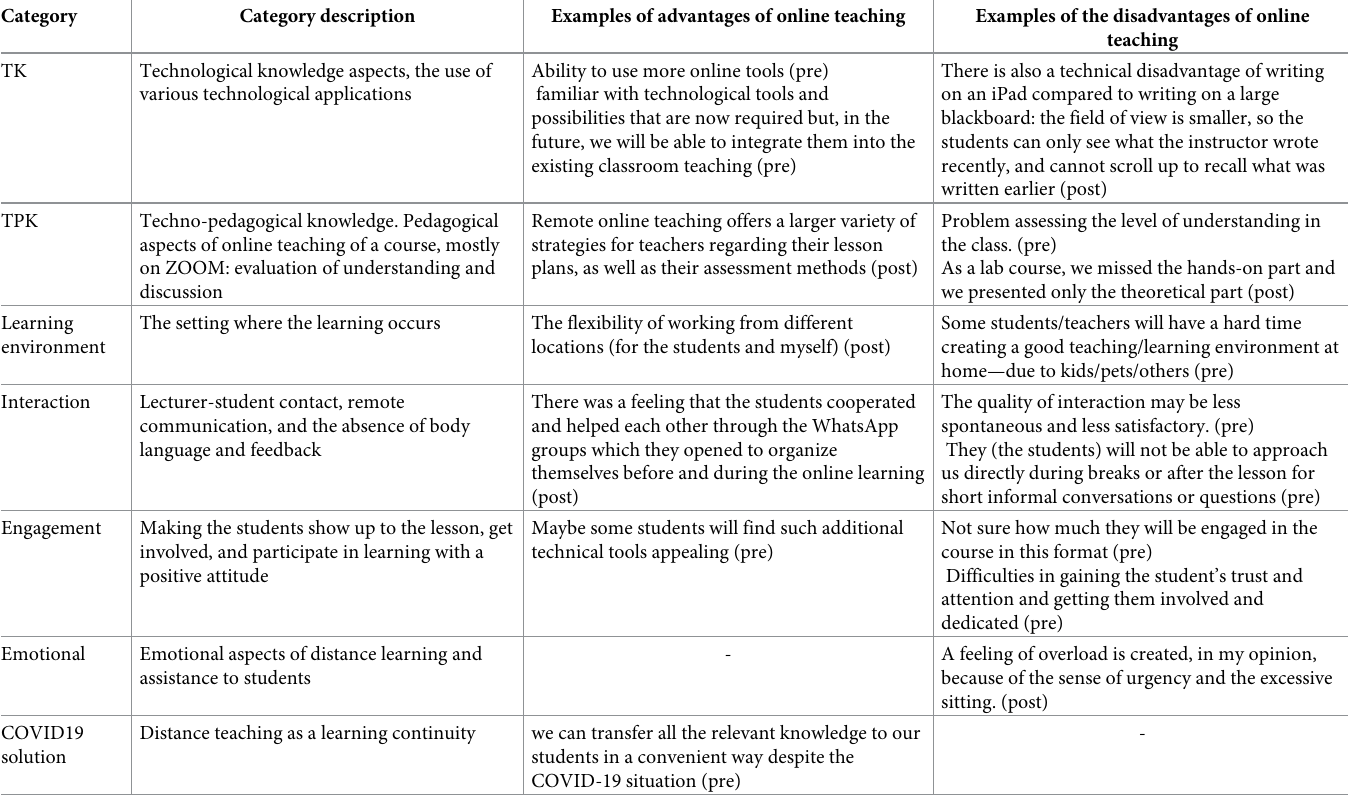
Table 4. Advantages and disadvantages of online teaching, categorized by TPACK